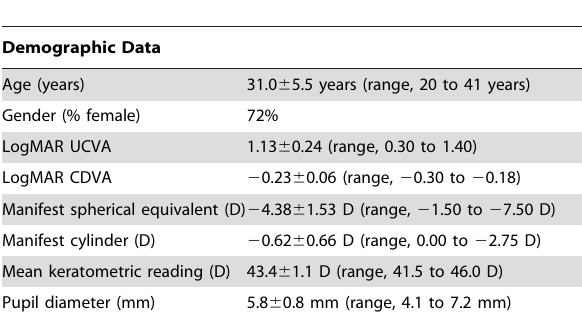
Table 1. Preoperative demographics of the study